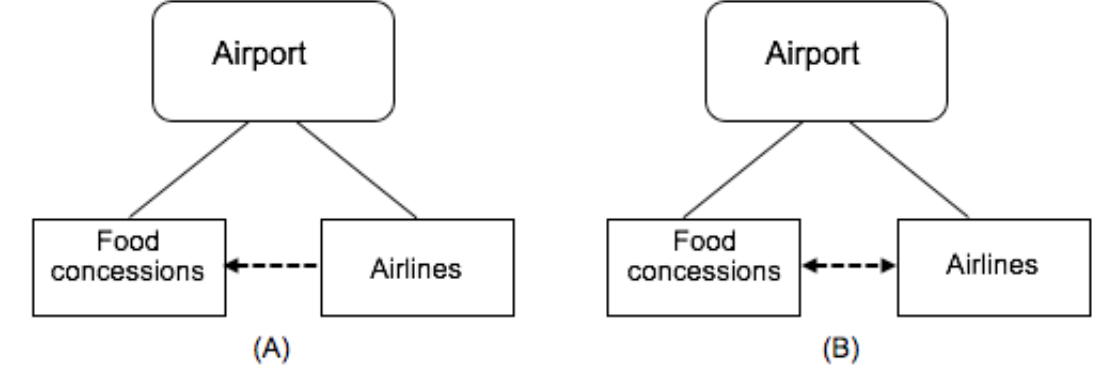
Figure 1. Network externalities in one- and two-sided airport